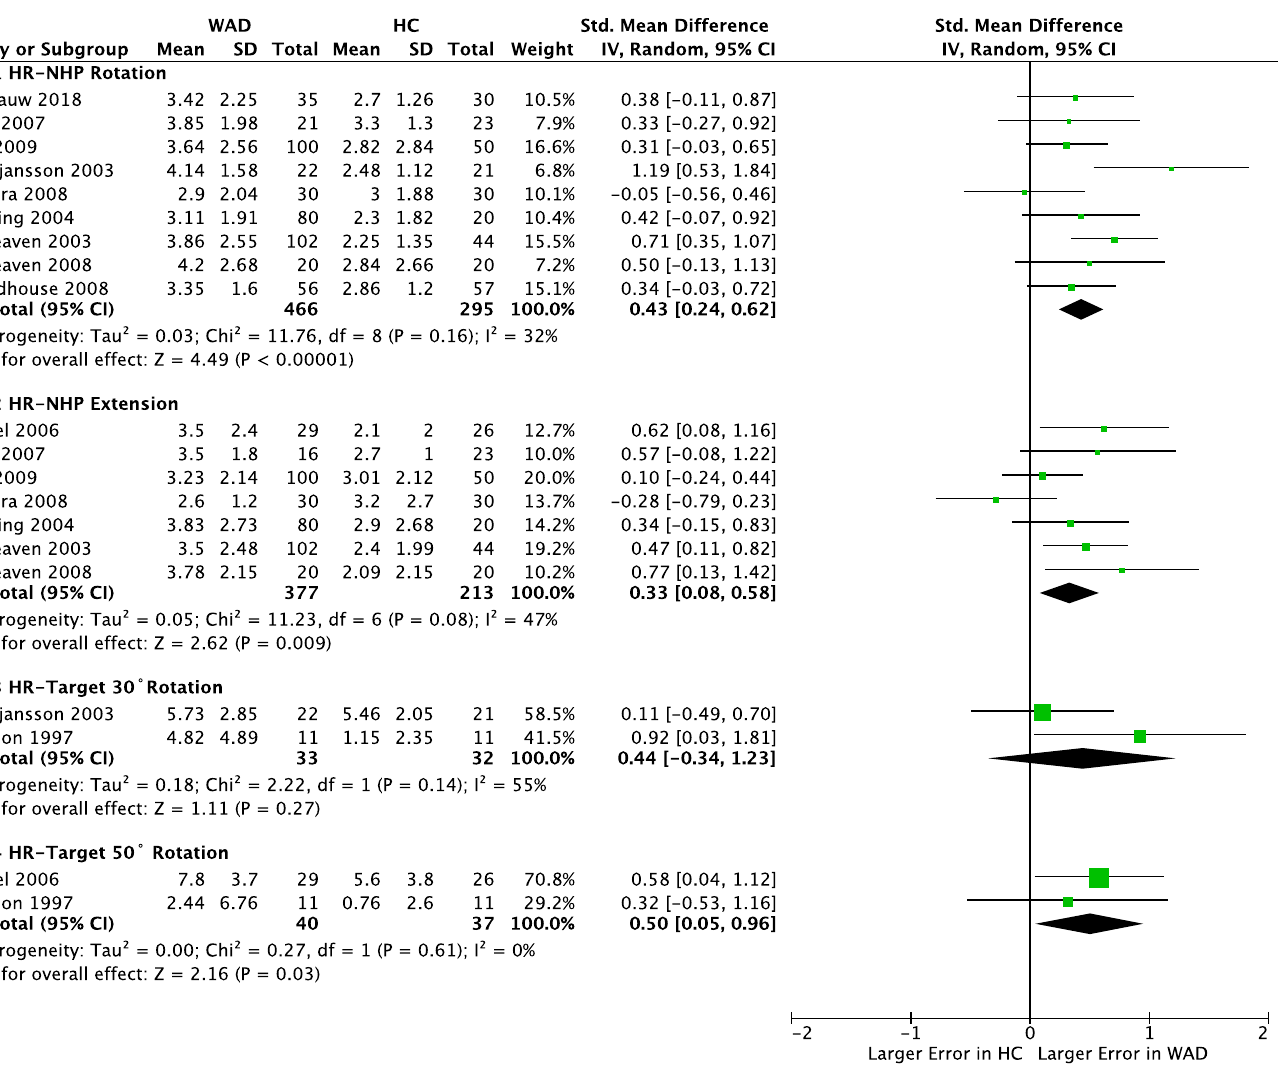
Fig 2. Forest plot demonstrating meta-analysis of absolute error (in degrees) of JPS when repositioning the head to neutral-head-position from extension and rotation and when repositioning the head toward targets set at 30˚ and 50˚ rotation from neutral-head-position in people with WAD vs. HC. WAD: whiplash- associated disorder; HC: healthy control; SD: standard deviation; IV: inverse variance; CI: confidence interval; Std: standardized.